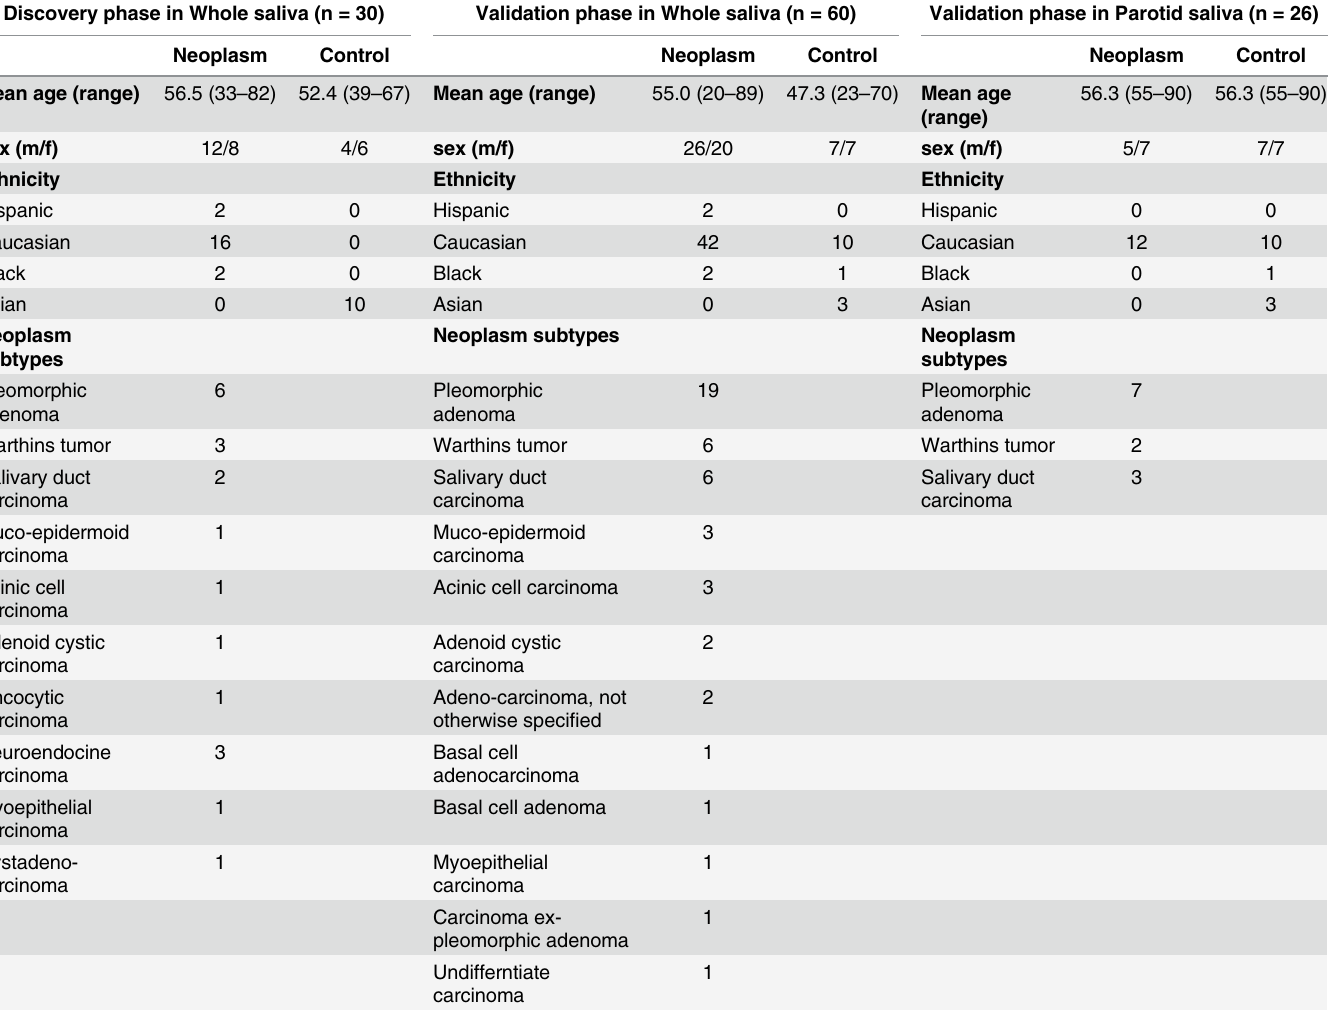
Table 1. Patients ’ characteristics. Patients ’ characteristics of neoplasm samples and control samples used in the discovery and the validation